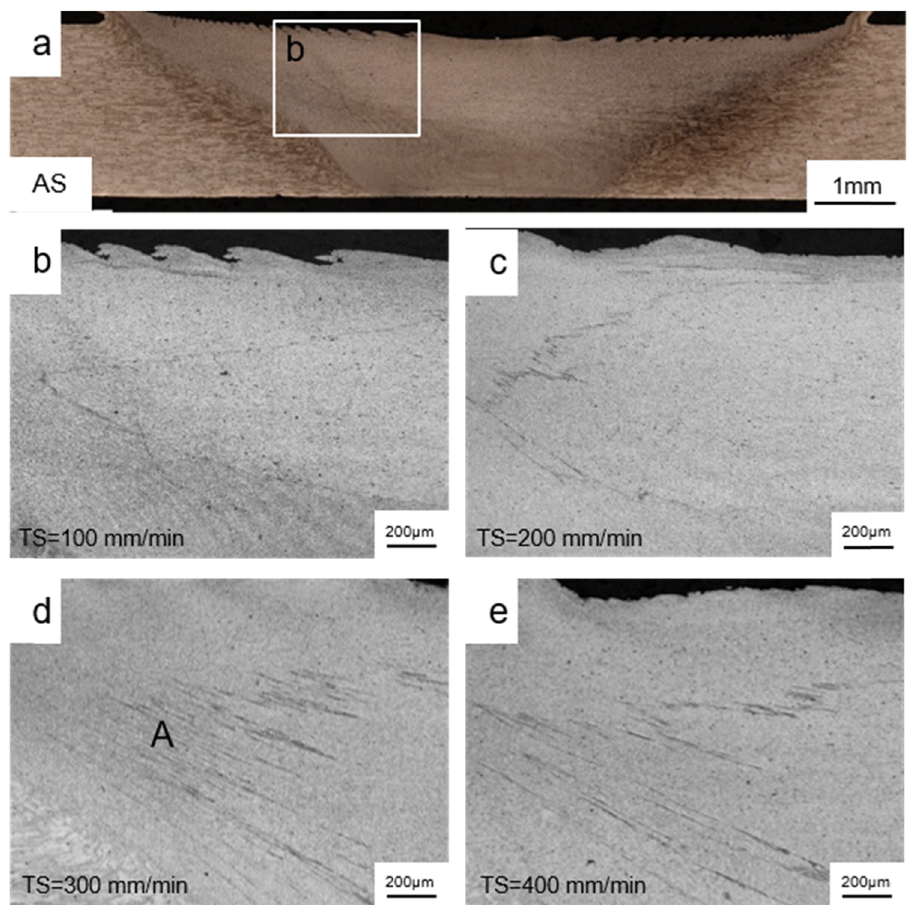
Figure 3: Macrostructure and JLR of A series ( butt welded directly ) : macrostructure of ( a ) A1; JLR of ( b ) A1, ( c ) A2, ( d ) A3, and ( e )